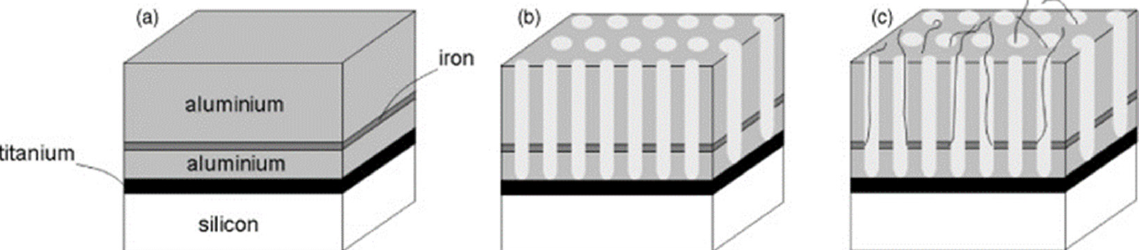
Figure 14. Schematic description of catalyst preparation inside PAA and CNT synthesis procedure. ( a ) Initial deposited film structure. ( b ) Anodized film structure. ( c ) CNTs synthesized from pore channels. Reprinted with permission from Ref. [11]. IOP Science Copyright © 2023.